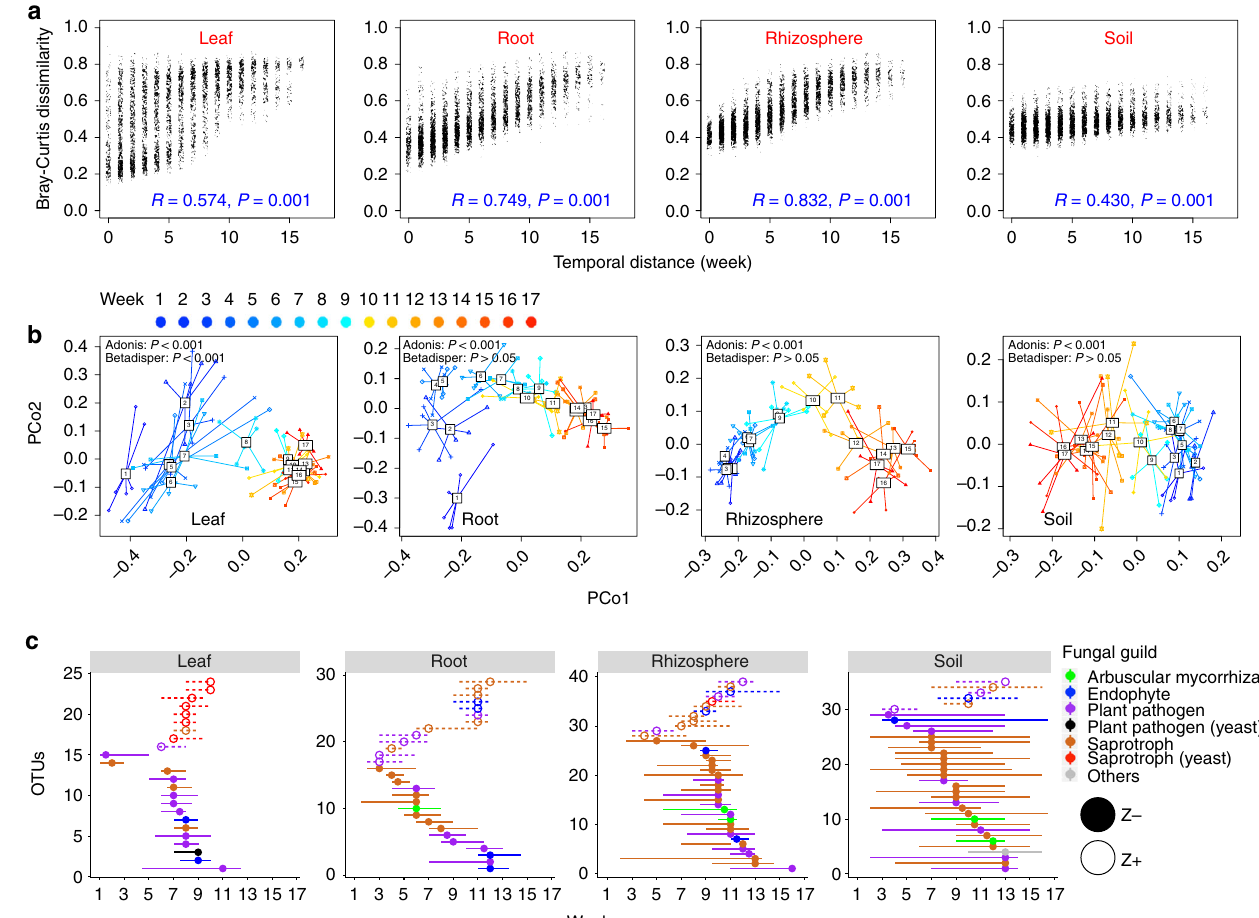
Fig. 3 Temporal dynamics of the sorghum mycobiome. a Succession is strong in leaf, root and rhizosphere, and weak in soil, based on Mantel testing of the correlation between temporal distance and Bray – Curtis community dissimilarity. b Turnover of fungal community composition demonstrated by Simpson dissimilarity among replicate plots and sampling times. Note strong fungal compositional turnover among weeks 1 – 9 in leaves followed by signi fi cantly less turnover for weeks 9 – 17. Similar strong turnover is seen among weeks 1 – 12 in roots, weeks 7 – 13 in rhizosphere, and weeks 9 – 13 in soil, but none is signi fi cantly different from other time points in these compartments. The Simpson metric differs from the Bray – Curtis and Jaccard metrics in that it is free from richness variance, as seen in our analysis of the sorghum root mycobiome (Supplementary Figs. 11 – 12) and our re-analysis (Supplementary Fig. 13) of the rice root microbiome of Edwards et al. 35 . c Temporal change of individual OTU abundance shown by threshold indicator taxa analyses (TITAN). For each OTU, functional guild is noted by color and fi lled symbols show declining abundance (z − ), and open symbols show increasing abundance (z + ). Genus names of the OTUs in each guild can be found in Supplementary Fig. 10. Source data are provided as a Source Data fi